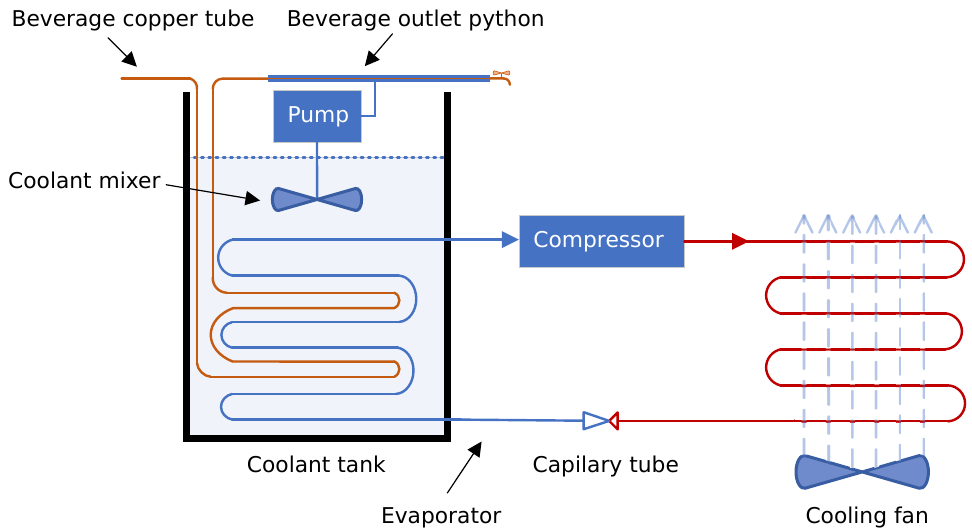
Figure 3. Working principle of our smart beverage cooling